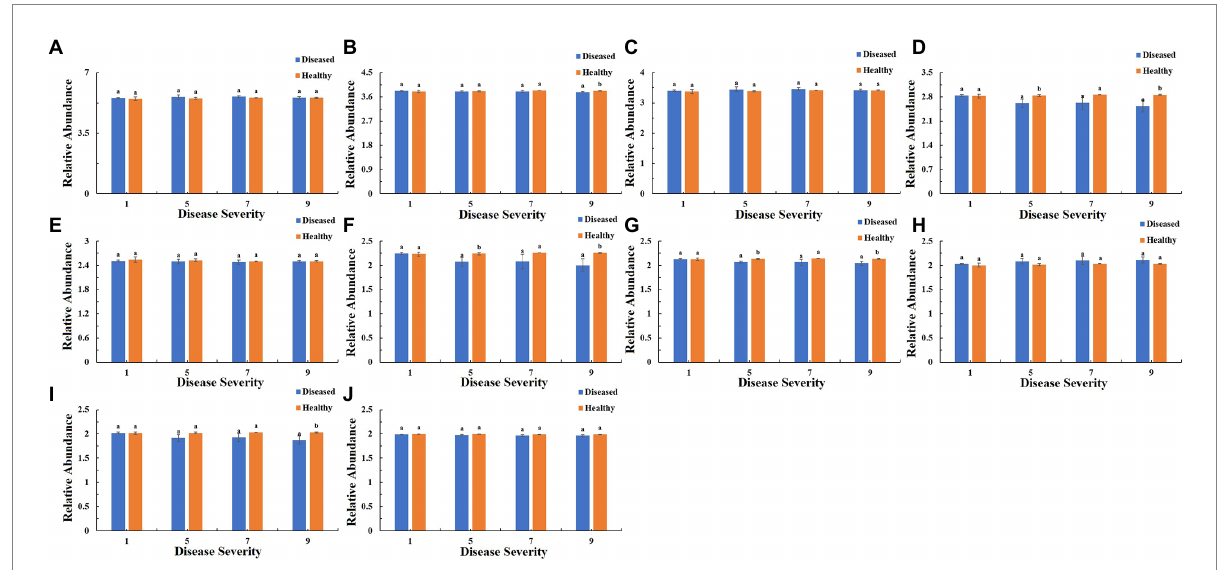
FIGURE 12 PICRUSt analyses of the changes in the KEGG level 3 functional categories of bacteria in tobacco leaf samples. (A) Transporters Ribosome, (B) General function prediction only, (C) ABC transporters, (D) Photosynthesis proteins, (E) DNA repair and recombination proteins, (F) Photosynthesis, (G) Peptidases, (H) Two component system, (I) Porphyrin and chlorophyll metabolism, (J) Purine